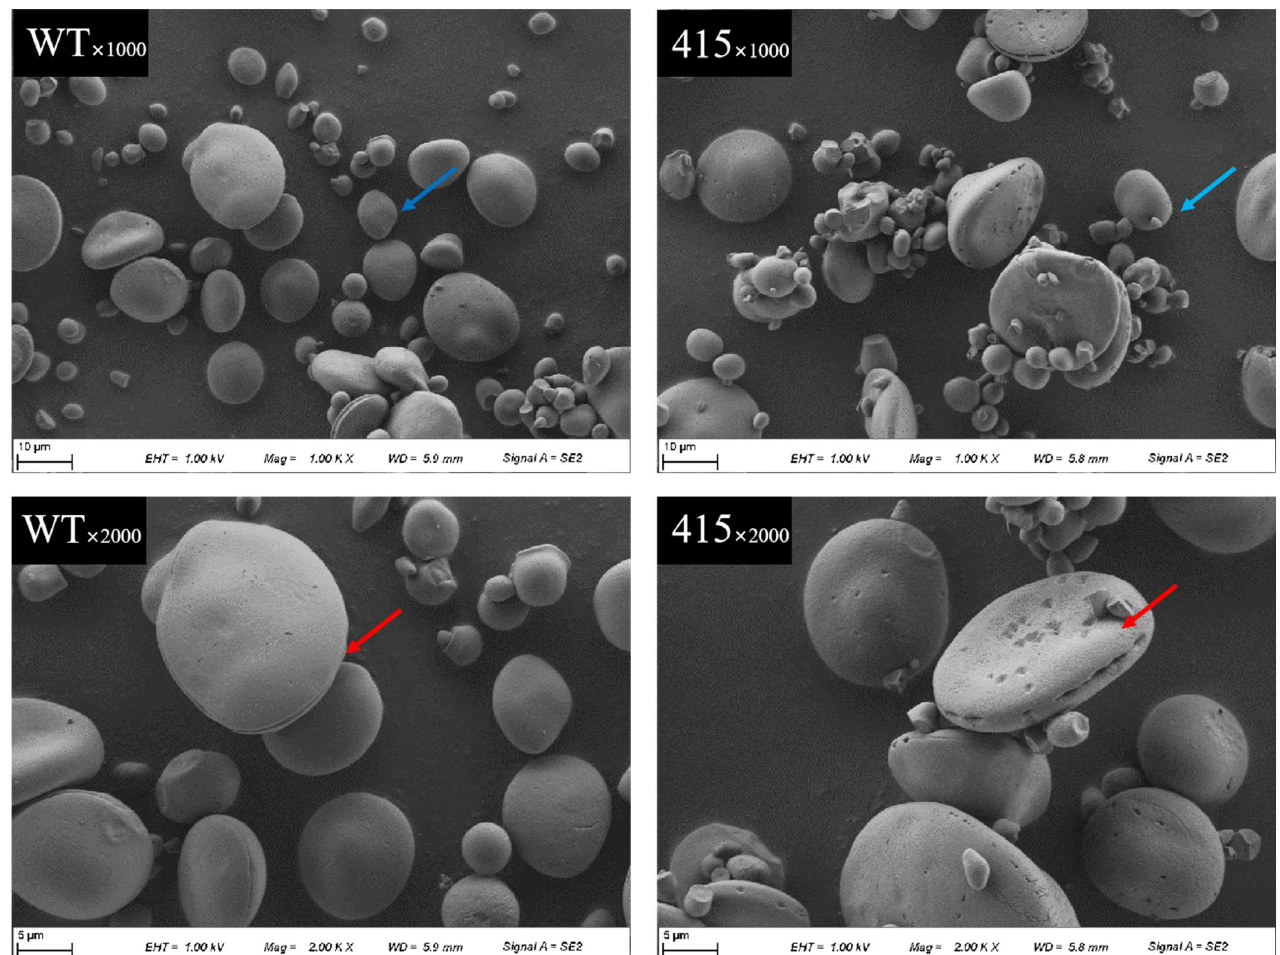
Table 2. Analysis of the thermal properties of starch in the WT and M3-415 lines.